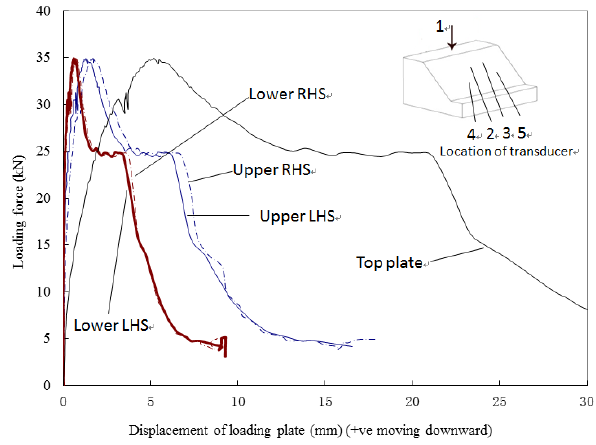
Figure 7. Loading force against the displacement of the slope sur-